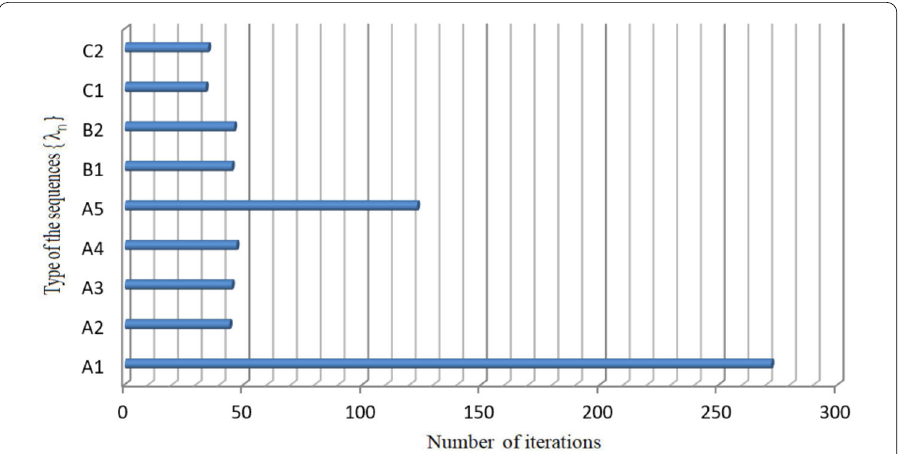
Figure 5 Benchmark for all choice types of the sequences { λ n } in example 4.8